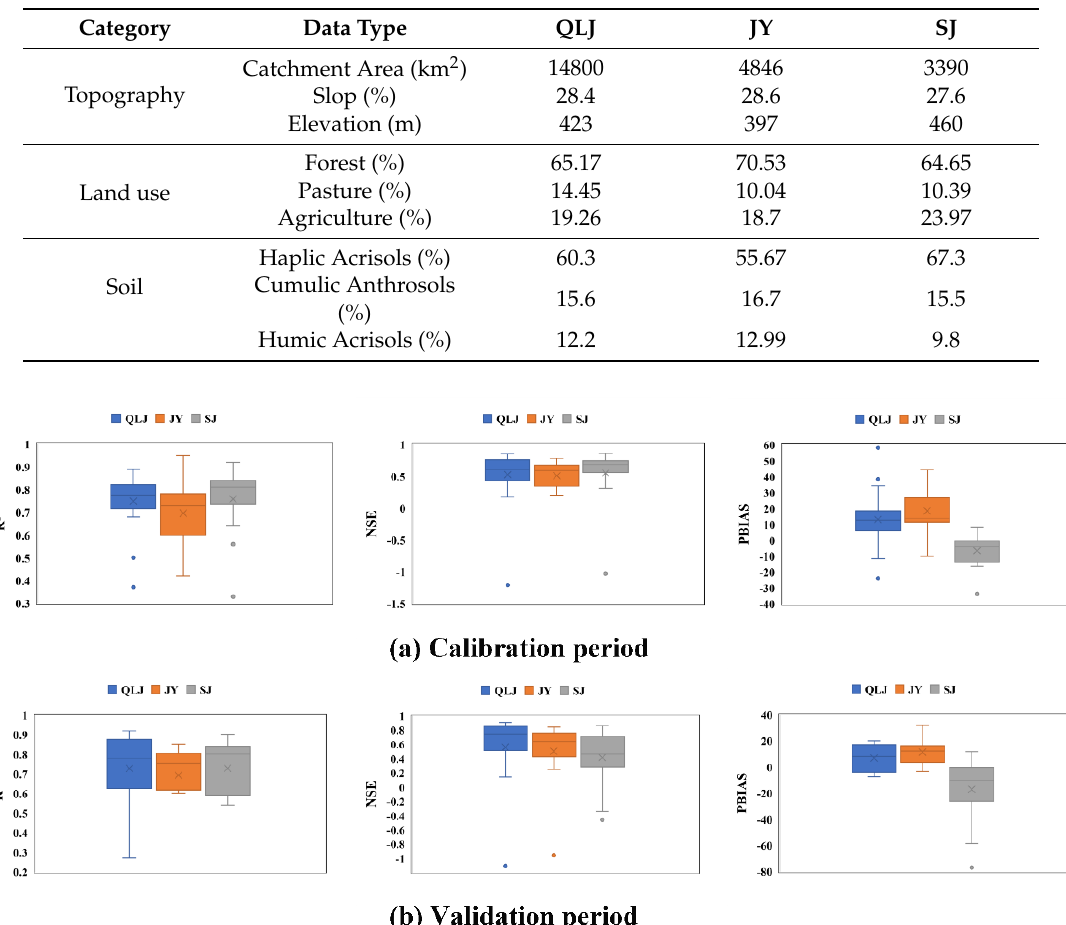
Table 6. Basic information of QLJ, JY and SJ stations.